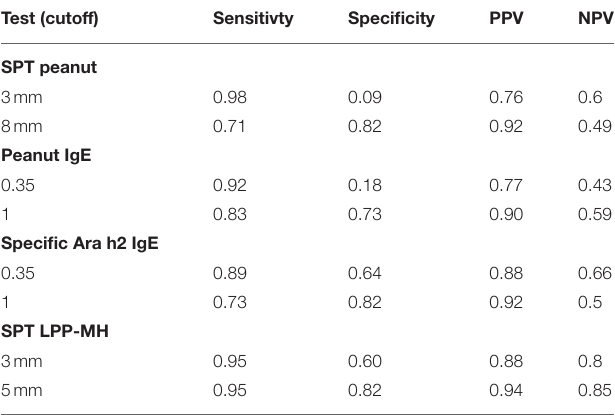
TABLE 3 | Sensitivity, specificity and positive and negative predictive values for peanut allergy, of skin tests and serum specific IgE to peanuts or Ara h2, in preschool children with a high suspicion of peanut allergy – i.e., prior probability of PA = 83/110 =